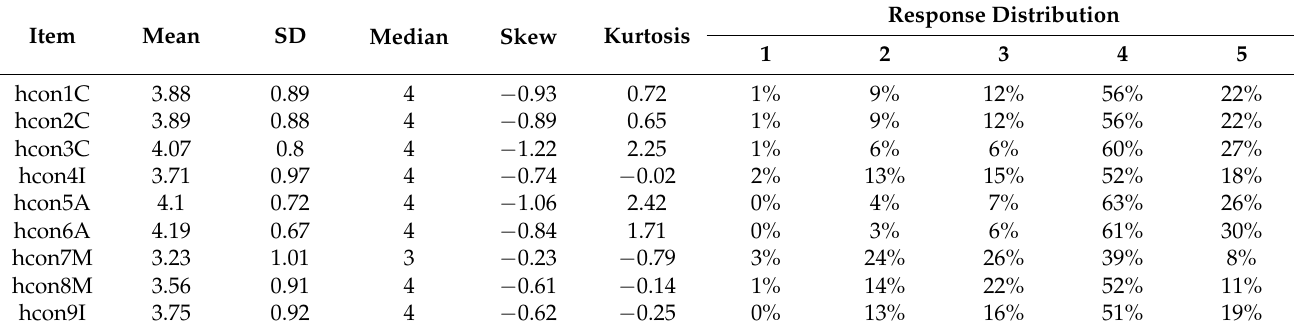
Table 2. Item statistics for all items of the health consciousness